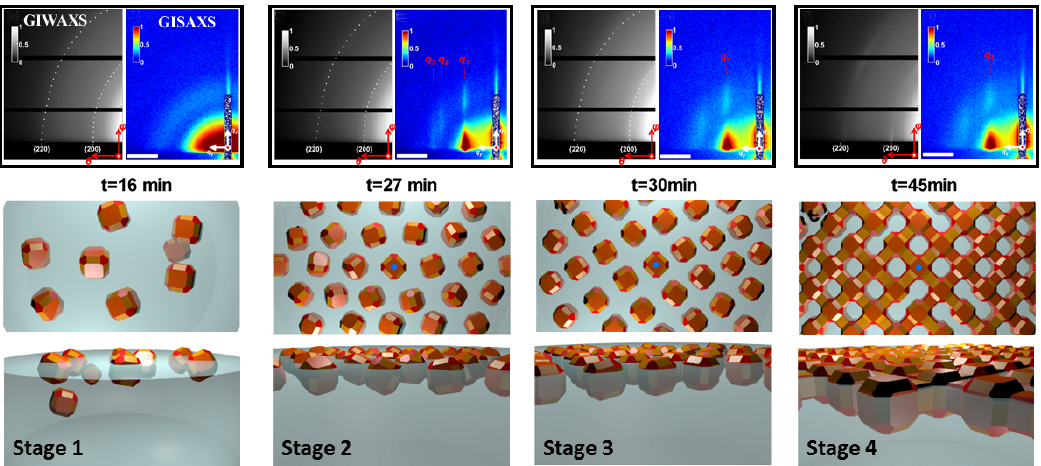
Figure 18. GISAXS and GIWAXS measurements during the self-assembly of PbSe nanocrystals. The lower panels display the corresponding structural models as side view (middle row) and top view (bottom row). All GISAXS scale bars denote 1 nm − 1 . Adapted from Geuchies et al. [149] c Nature